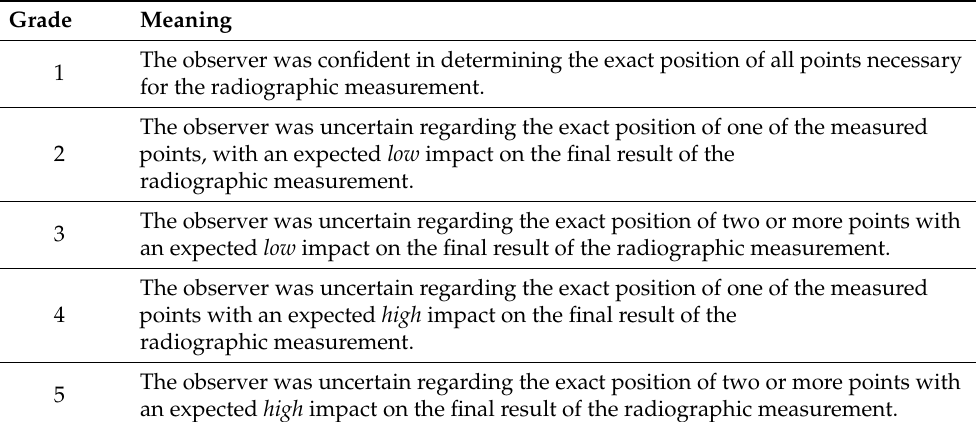
Table 1. Explanation of the grading system for the radiographic measurements.